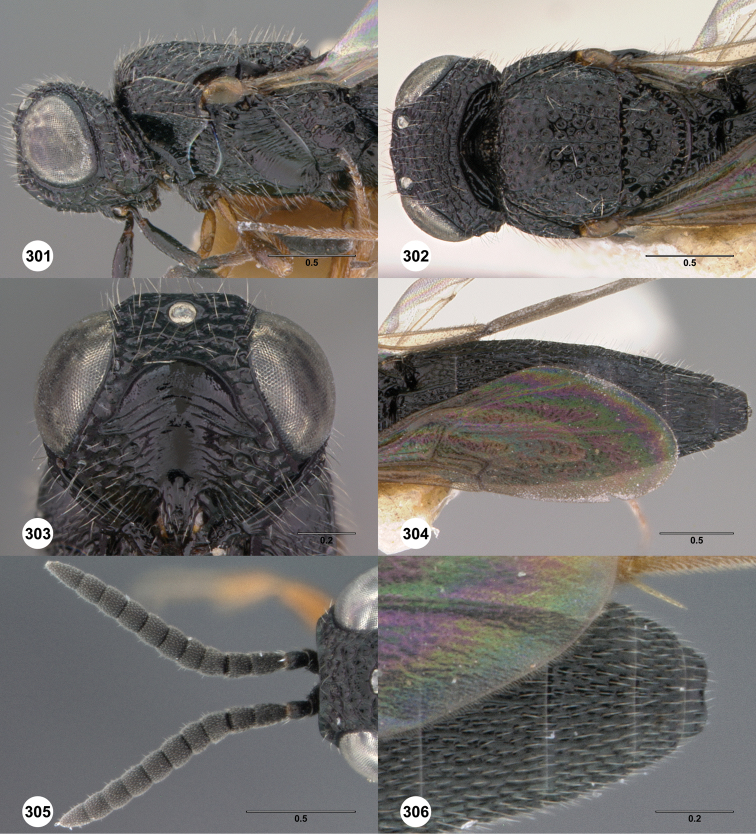
Oxyscelio scismatis sp. n., holotype female (OSUC 436037) 301 Head and mesosoma, lateral view 302 Head and mesosoma, dorsal view 303 Head, anterior view 304 Metasoma, dorsal view. Paratype male (OSUC 456181) 305 Antenna 306 Metasoma, dorsal view. Morphbank85